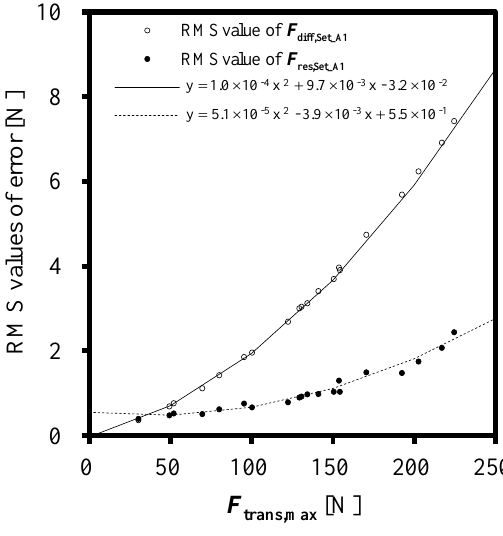
= F − F and RMS diff trans mass = F − F . res corrected mass